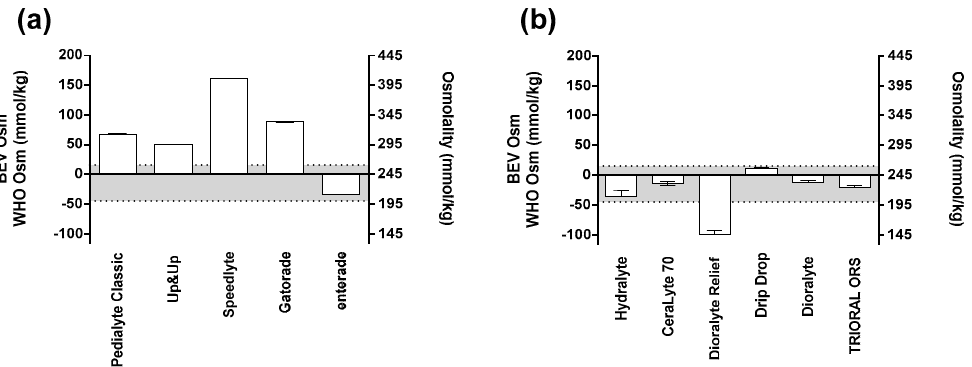
Figure 2. Beverage osmolality for: ( a ) pre-mixed solutions; and, ( b ) reconstituted powders. The left y-axis denotes the di ff erence between beverage and WHO-UNICEF osmolality; the right y-axis denotes the absolute beverage osmolality. Each bar represents the median value for the three bottles tested. The variation plotted represents the range. The horizontal dotted lines denote the optimal range for beverage osmolality (200–260 mmol/kg; see text for details).